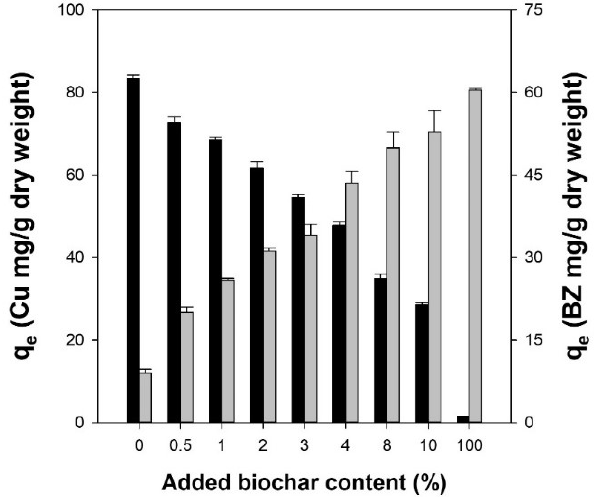
Figure 3. Adsorption capacities of alginate hydrogel beads, alginate/biochar hydrogel beads, and biochar for Cu 2+ (black bars) and benzene (gray bars) at equilibrium.